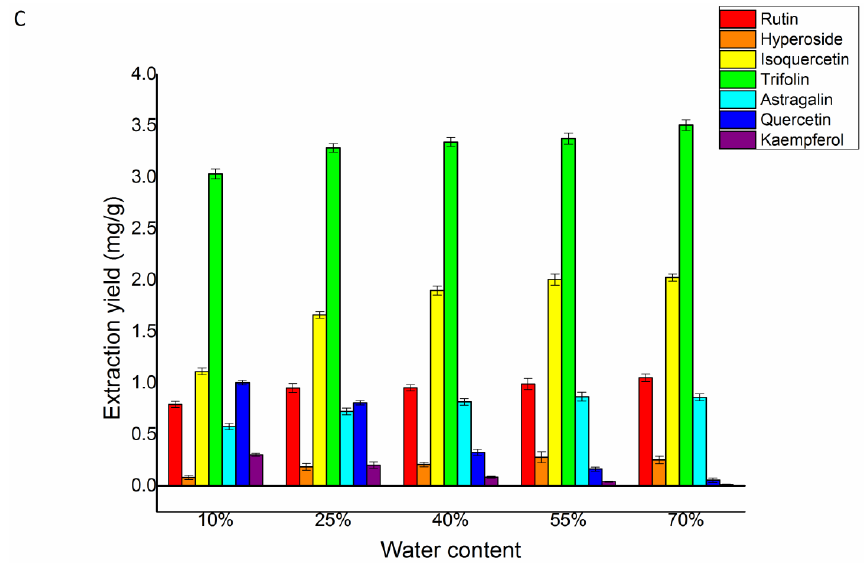
Figure 4. Effects of different DESs ( A ), choline chloride/lactic acid ratio ( B ), and water content of DESs ( C ) on the extraction yield of rutin, hyperoside, isoquercetin, trifolin, astragalin, quercetin, and kaempferol in Ribes mandshuricum leaves.